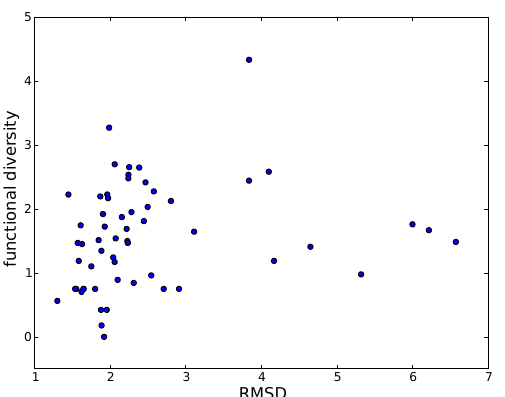
Figure 5: Scatter showing average RMSD of superfamily against functional diversity (depth weighting